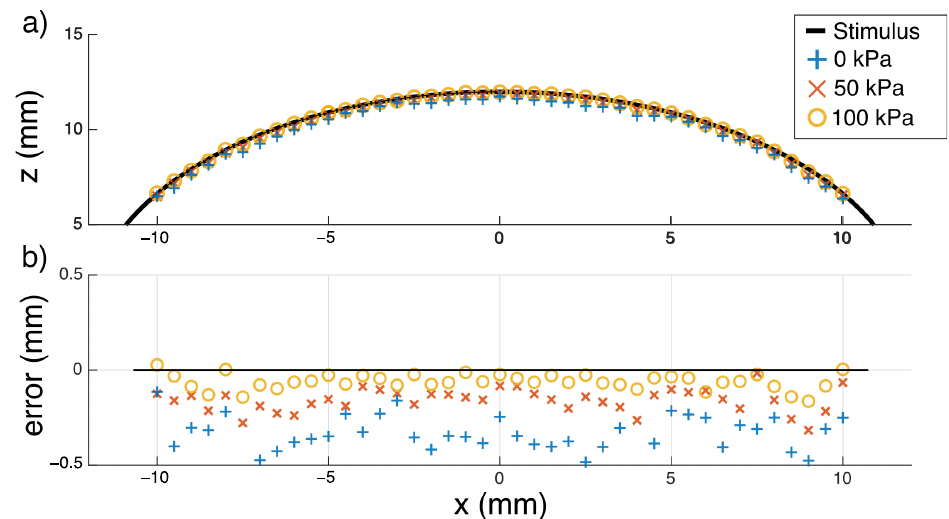
Figure 9. A circle fitted to the sensor’s output ideally matches the known diameter of the real soft object. ( a ) Reconstruction of a section through centre (y = 0) of a sphere of known radius (12 mm). The back-pressure states at 0, 50, and 100 kPa returned calculated radii of 11.66 mm, 11.84 mm, and 11.94 mm, respectively. ( b ) Plotting just the error shows that the higher pressure state is more accurate at sensing the edge of the soft object, but all states consistently return an error of less than half a millimetre.